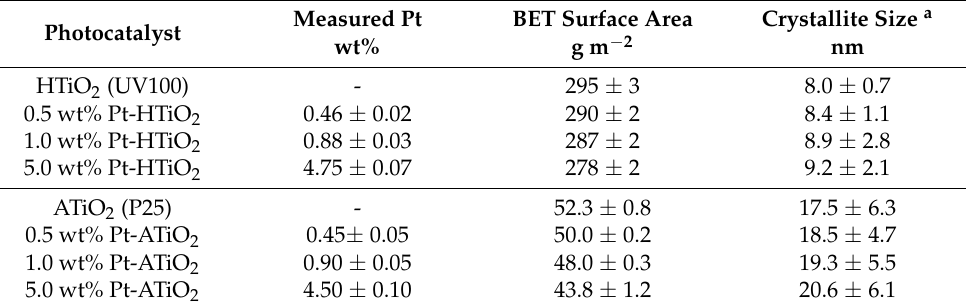
Table 1. Actual loaded Pt nanoparticles percentage, BET surface area, and crystallite size for the pristine and as-prepared platinized TiO 2 .